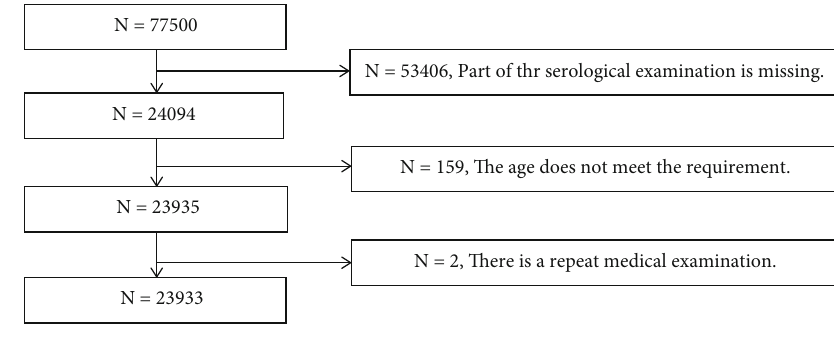
Figure 1: Flow diagram.